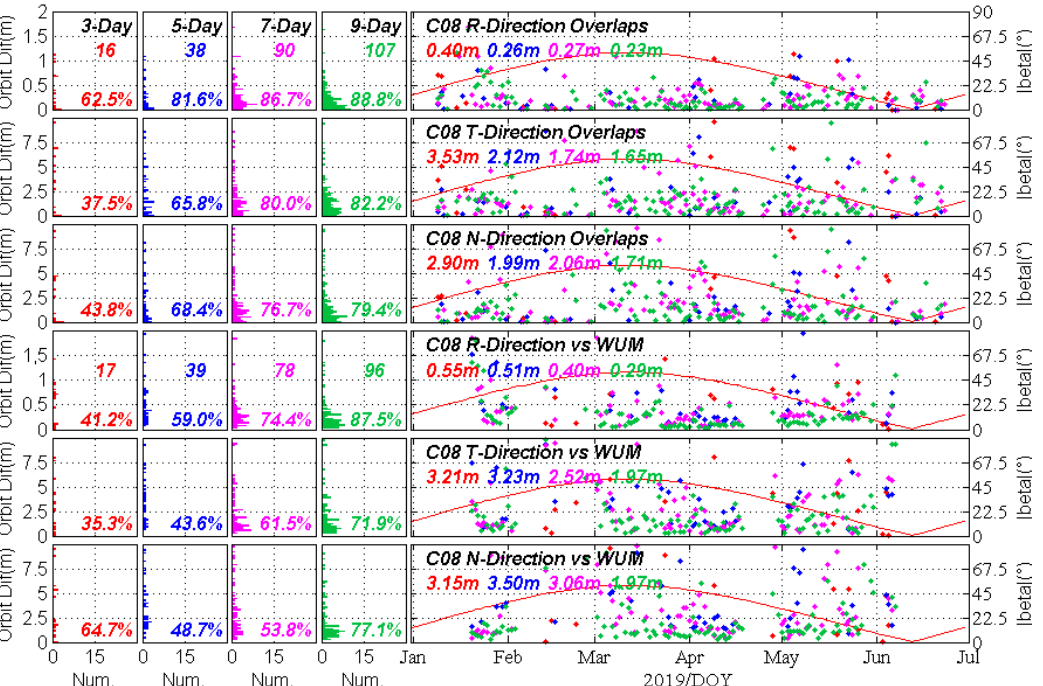
Figure 7. The results of SLR-only orbit determination for C08.